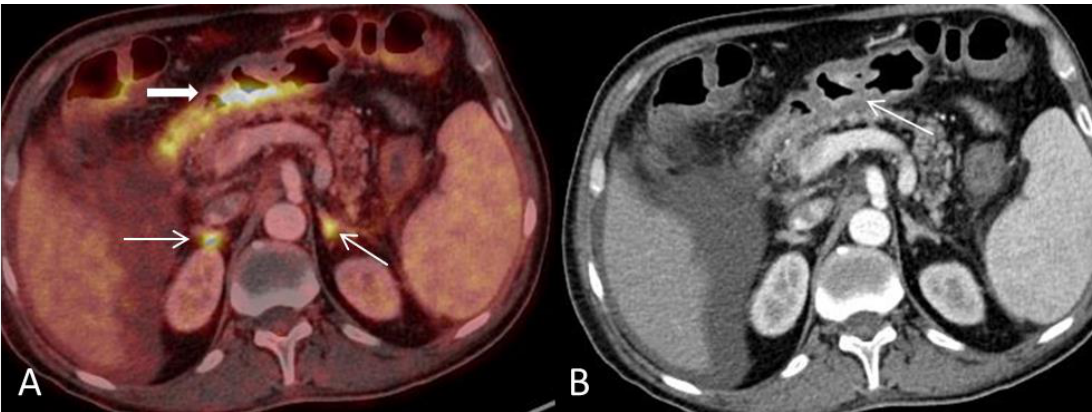
Figure 5. ( A ) Axial PET and CT fused image shows pathological FDG-uptake in the wall of antrum and to a lesser degree in pylorus (bold arrow). Both adrenal glands are seen with high FDG-uptake with no morhological changes, the foci were intepreted as physiological and most likely stress-related (arrows); ( B ) Axial CT shows thickening of the antrum wall with mucosal enhancement (arrow). Ascites surrounding the liver is also present.